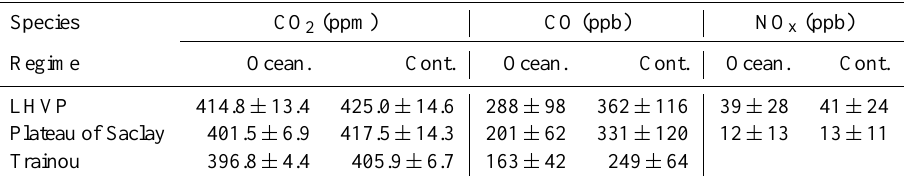
Table 2. Average of the CO 2 , CO and NO x mole fractions, with their respective standard deviation, as a function of the air mass origin at the LHVP, Plateau of Saclay and Trainou sites from 15 January to 19 February 2010.